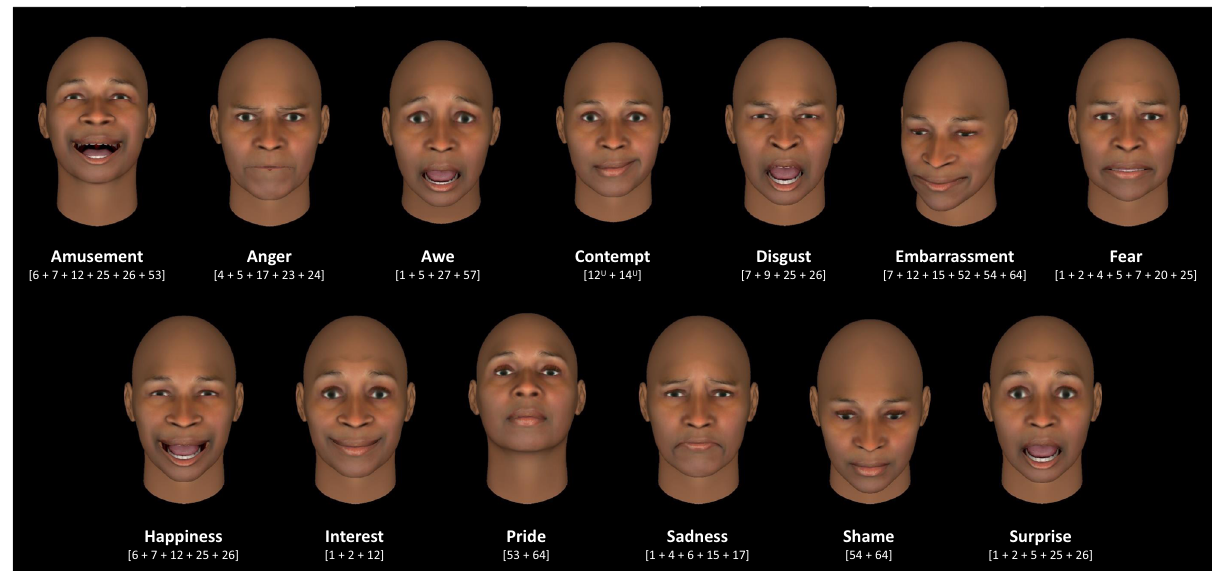
Fig. 1 Examples of hypothesized facial con fi gurations for emotion categories, based on the facial action units (AUs) listed in Supplementary Table 1. All facial con fi gurations except “ awe ” and “ contempt ” based on those depicted in ref. 12 ; “ awe ” con fi guration based on ref. 9 ; “ contempt ” con fi guration based on ref. 96 . Facial con fi gurations were created in FaceGen (Singular Inversions, Inc., Toronto, ON, CA), with AUs set to 100% intensity, except where this would yield visible distortions — in those cases, AUs were set to 80%